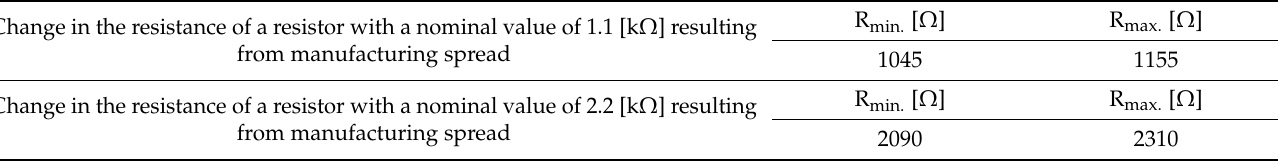
Table 2. Permissible ranges of the resistance reached by real resistors with the nominal values of 1.1 [k Ω ] and 2.2 [k Ω ], at a manufacturing spread of 5%.